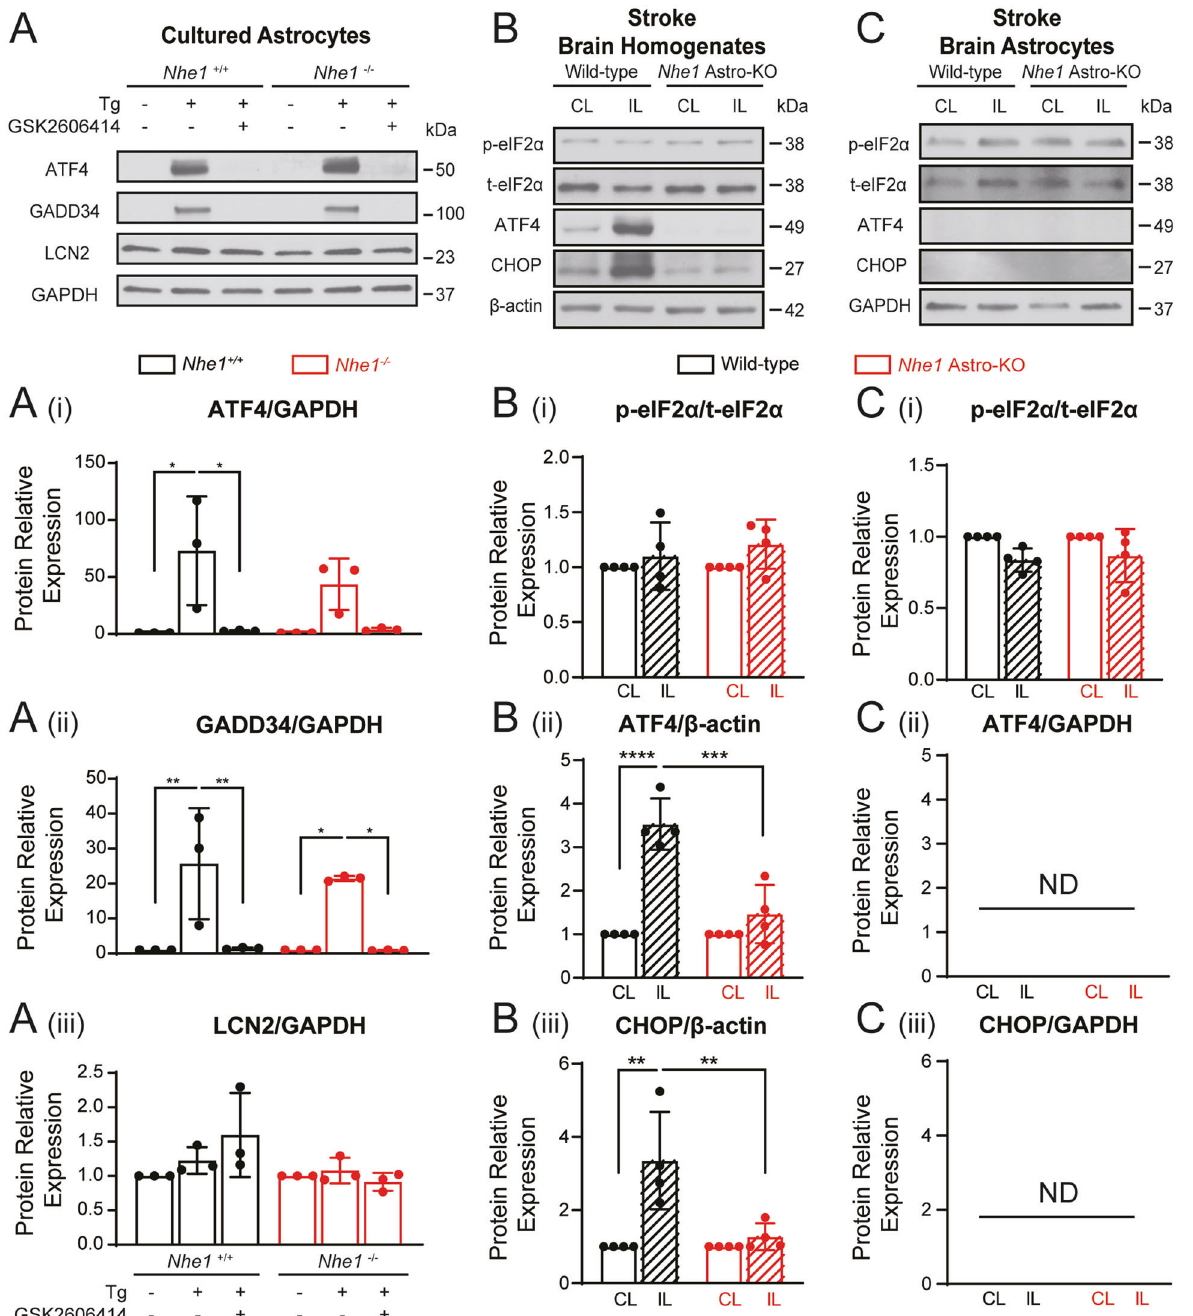
Fig. 3 ER stress response-related protein activation in wild-type and Nhe1 Astro-KO brains. A Representative immunoblots showing the expression of ER stress proteins in astrocyte cultures from wild-type ( + / + ) and global Nhe1 KO ( − / − ) mice treated with ER stress inducer thapsigargin (Tg) 100 nM or the pathway inhibitor GSK2606414 (5 μ M) for 24 h. (i-iii) Summary. Data are mean ± SD, n = 3. * p < 0.05; ** p < 0.01 via one-way ANOVA. B, C are representative immunoblots showing the expression of ER stress proteins in brain homogenate and astrocytes isolated from wild-type and Nhe1 Astro-KO brain at 24 h Rp. CL Contralateral, IL Ipsilateral hemisphere. (i-iii) Quanti fi cation of p-eIF2 α /t-eIF2 α , ATF4 and CHOP protein bands. Data are expressed as relative change (fold) of the CL controls. Data are mean ± SD , n = 4. * p < 0.05; ** p < 0.01; *** p < 0.001; **** p < 0.0001 via one-way In vitro ischemia-induced astrocytic LCN2 secretion caused LCN2 proteins [34]. The prominent 28 kDa LCN2 band in exosomes neurodegeneration was reduced by the tunicamycin treatment but not abolished, To test our hypothesis that increased LCN2 expression in RA implying for the presence of additional N-glycosylation sites of causes adjacent neuron degeneration in wild-type stroke brains, LCN2 in exosomes from ACM. Together, these data suggest that we fi rst evaluated the effect of recombinant LCN2 (Re-LCN2) RA secrete LCN2 protein packaged in the exosomes and astrocytic protein on neuronal viability and degeneration in cultures. Primary NHE1 protein activity is involved in LCN2 expression and secretion.